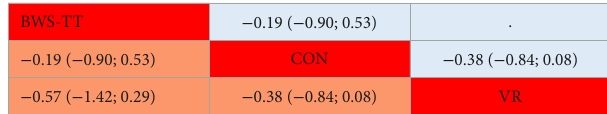
TABLE 3 League table for static steady-state balance estimate gait training according to their relative effects and 95% credibility intervals (95% CIs).